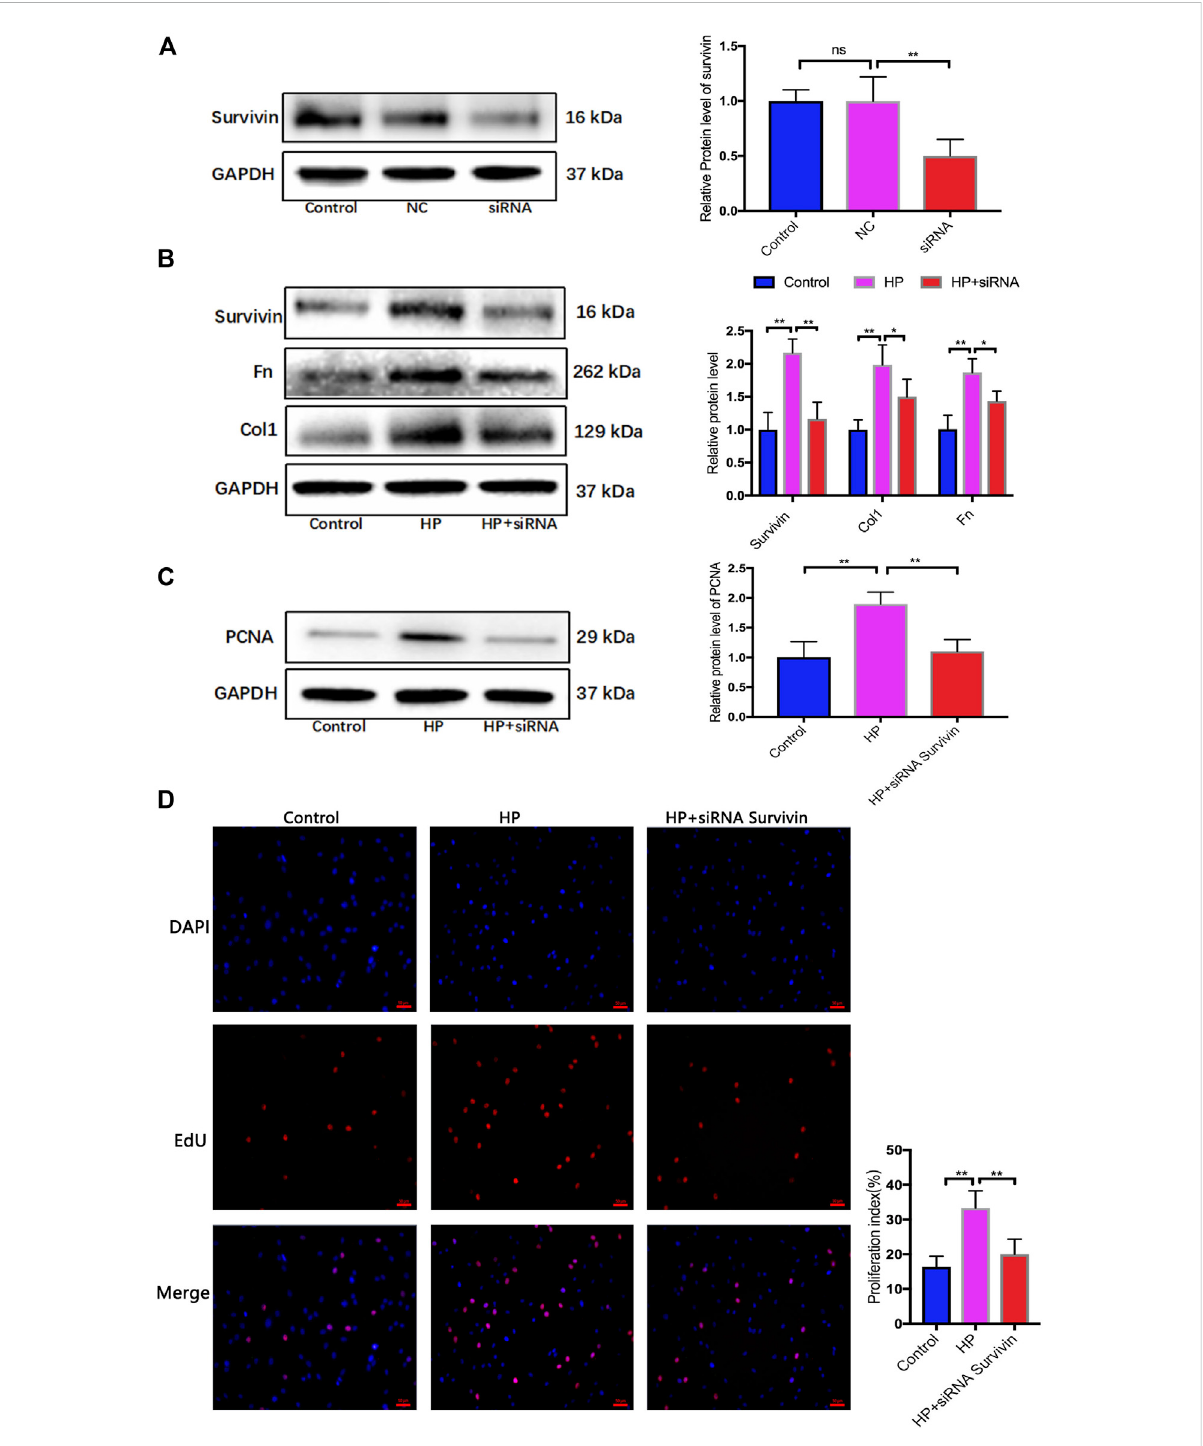
FIGURE 4 The pathological pressure-upregulated survivin enhanced the collagen expression and cell proliferation of hBSMC. (A) Knockdown of survivin protein by siRNA survivin. (B) hBSMC exposure to 200 cm H 2 O for 24 h increased the expression of collagen accompanied by the upregulation of survivinprotein,whileknockdownofsurvivinattenuatedthesechanges. (C) Knockdownofsurvivinsuppressed thePCNAexpression induced byHP. (D) EdUassaywasusedtodeterminetheproliferationofhBSMCs( n =3).** p < 0.01;*p < 0.05 ;(Kruskal-Wallis1-wayANOVA).Scalebar:50 μ